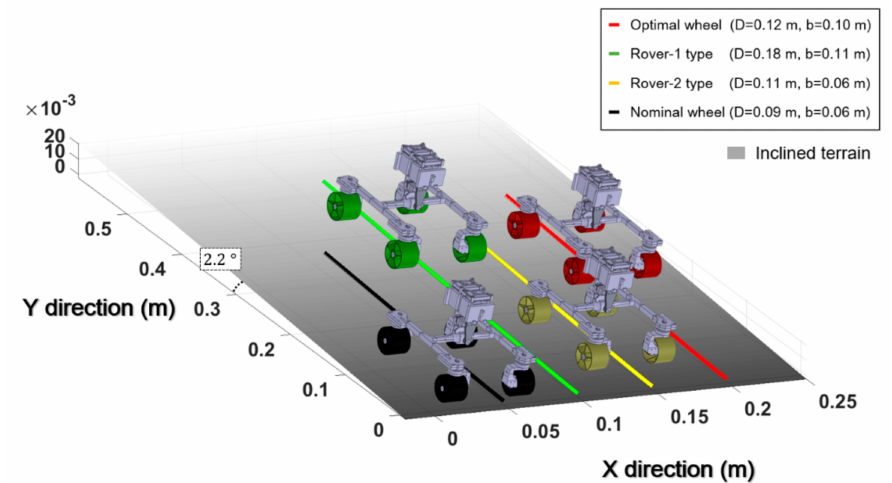
Figure 16. Illustration of paths for various rover testbed models, where each rover climbs 2.2 ◦ inclined deformable terrain in the case of the landing site at 44.12 ◦